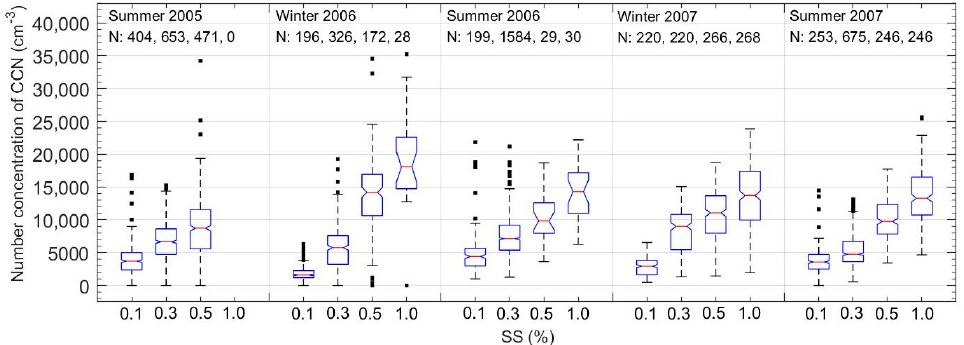
Figure 6. An overview of hourly–averaged N CCN . All the data are divided into five groups that present different observation periods. Each group contains four SS levels, namely 0.1%, 0.3%, 0.5% and 1.0%. “N” means the number of samples in different SS. On each box, the central mark (red line) indicates the median, and the bottom and top edges (blue line) of the box indicate the 25th and 75th percentiles, respectively. The outliers are plotted individually using the point symbol.